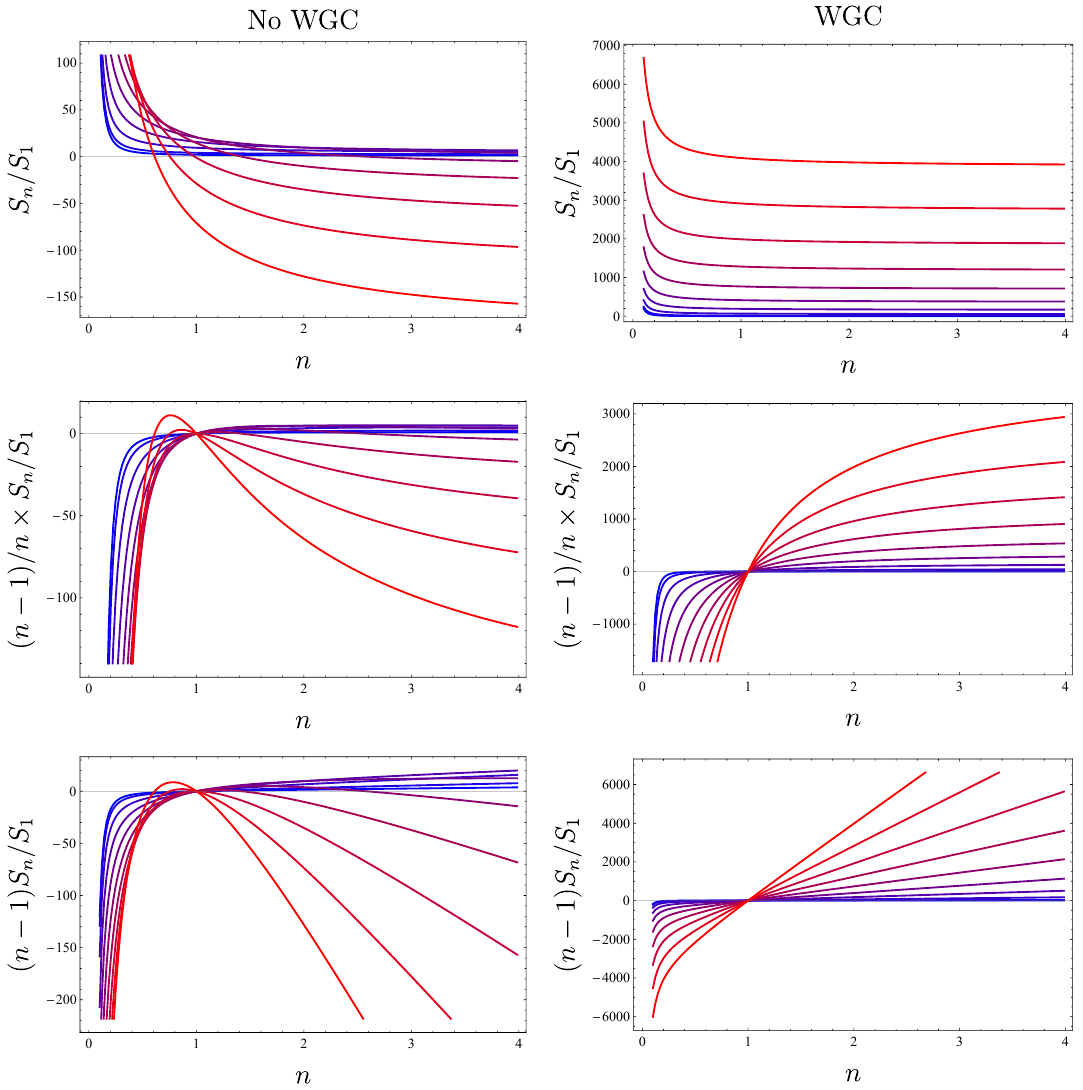
Figure 9. Rényi entropies as function of n for two particular choices of couplings in d = 4 . From blue to red, the different curves correspond to ¯ µ/ unitarity constraints but not the WGC: { λ, α theory that satisfies both unitarity and WGC bounds: { λ, α The standard properties of Rényi entropies may be violated if the WGC is not